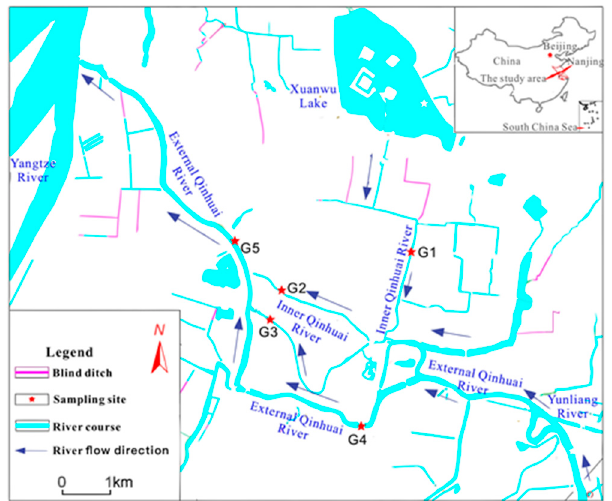
Figure 1. The monitoring sites of Nanjing. G1: Yixian Bridge (32°02.490 ′ N, 118°47.898 ′ E), G2: Wenjin Bridge (32°02.145’ N, 118°46.099 ′ E), G3: Xiafu Bridge (32°01.750 ′ N, 118°46.051 ′ E), G4: Yuhua Bridge (32°00.577 ′ N, 118°47.283 ′ E), and G5: Hanzhongmen Bridge (32°02.619 ′ N, 118°45.609 ′ E). The arrows in the graph show the direction of water flow.